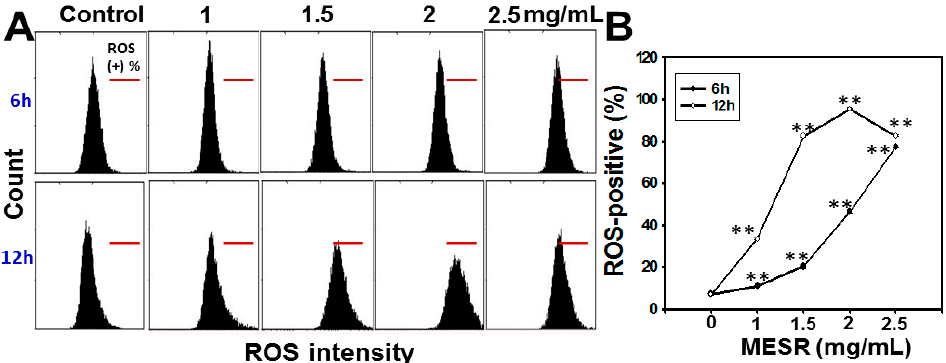
horizontal red lines in each plot indicated ROS-positive (%). ( A ) Typical ROS patterns of MESR-incubated Ca9-22 cells. ( B ) Statistics of ROS-positive intensity (%) in Figure 4A. Data, means ± SDs ( n = 3). ** p < 0.001 against control.